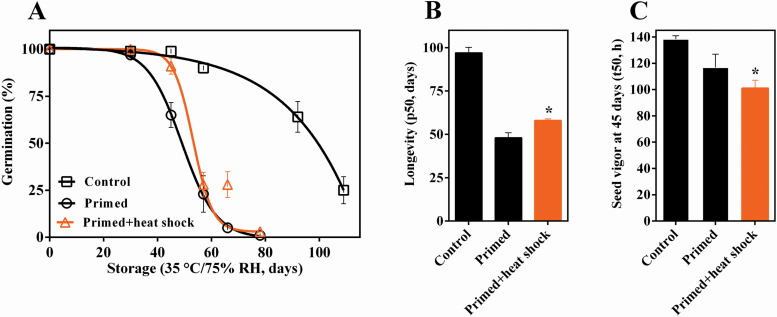
Priming decrease longevity in S. lycopersicum seeds while it is enhanced by heat shock treatment. Germination during storage (A) longevity (B) and seed vigor—t50—at 45 days in S. lycopersicum seeds control non-primed, primed and primed+heat shock treatment (38 °C/32 % RH). Germination during storage was fitted with Boltzmann sigmoid [y= top+(bottom-top)/1+[v50−(x/slope)]].*Significance difference (P ≤ 0.05) by t-test between primed and primed+heat shock samples (n = 4). Error bars show standard deviation.